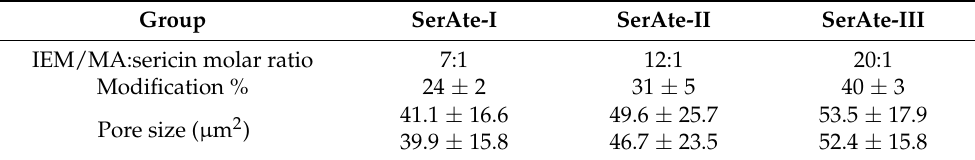
Table 1. The degree of methacrylation of sericin as a function of molar ratio of IEM to serine or MA to serine (IEM/MA:serine). Group SerAte-I SerAte-II